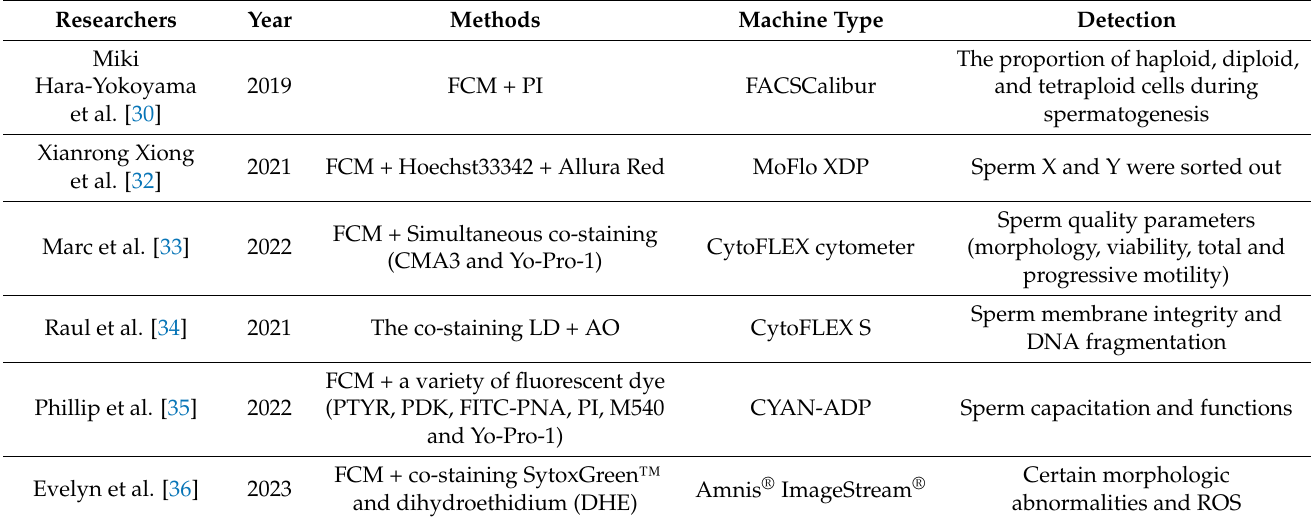
Table 1. Part of the literature on the changes of FCM used in sperm